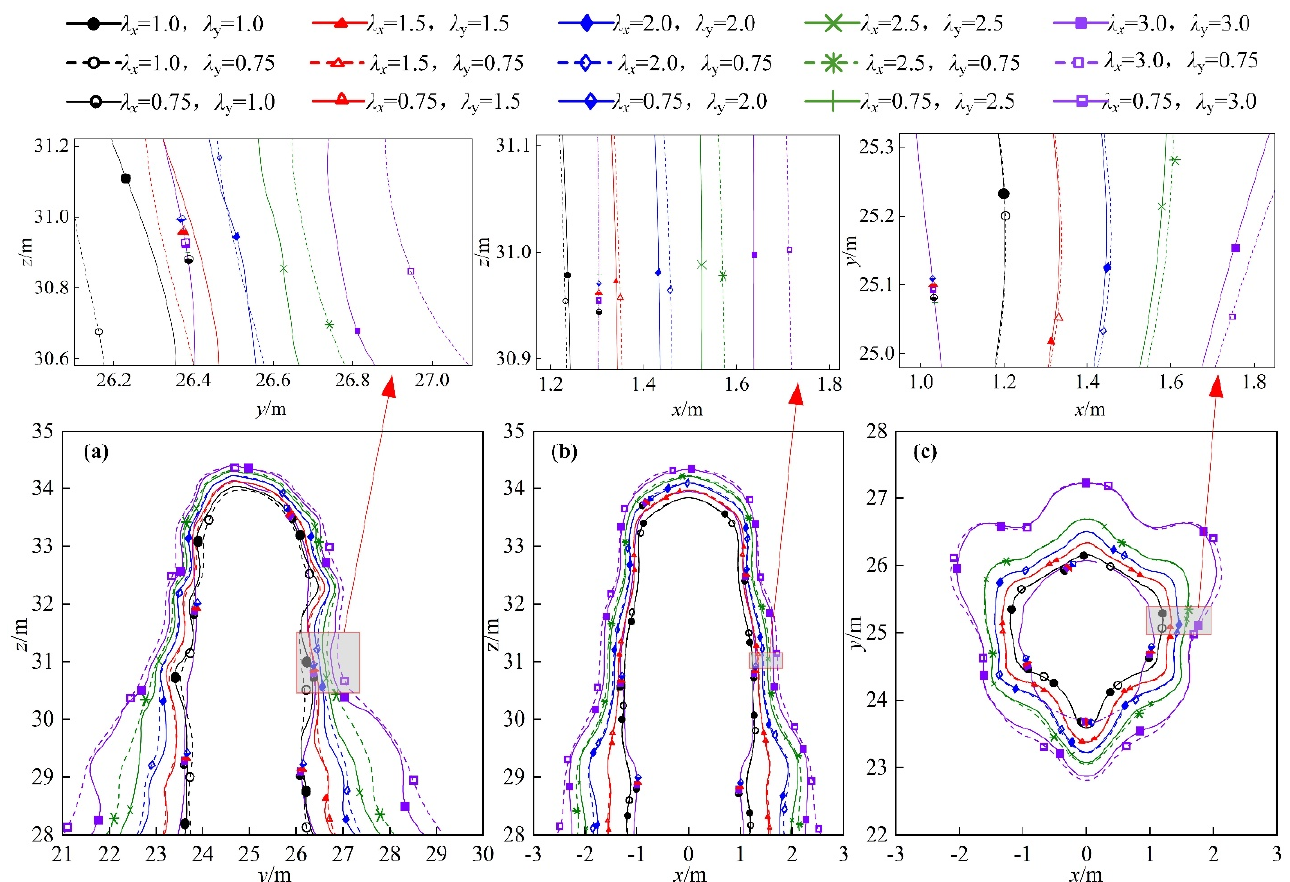
Figure 8. Diffusion length of grout under different lateral pressure coefficients. ( a ) Diffusion range of grout on yz plane; ( b ) diffusion range of grout on xz plane; ( c ) diffusion range of grout on xy plane. The attenuation law of the grout pressure head is similar to that of horizontal lateral pressure coefficient λ x = λ y when the horizontal lateral pressure coefficient λ x > λ y .